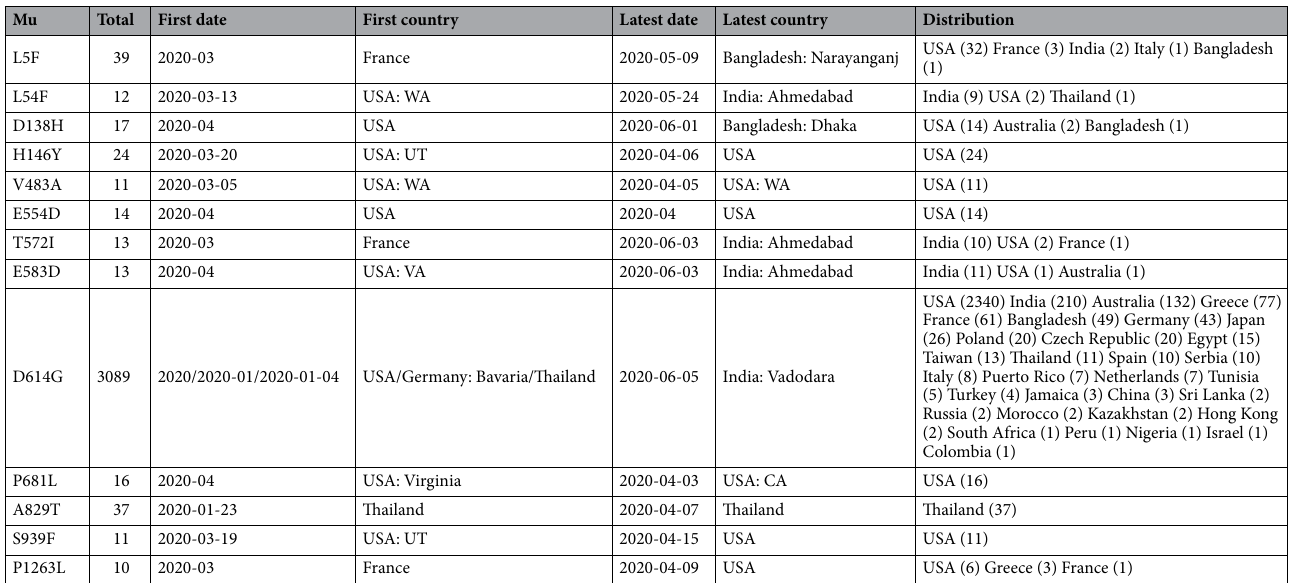
Table 10. Gene S—nonsynonymous mutations that occur in 10 or more